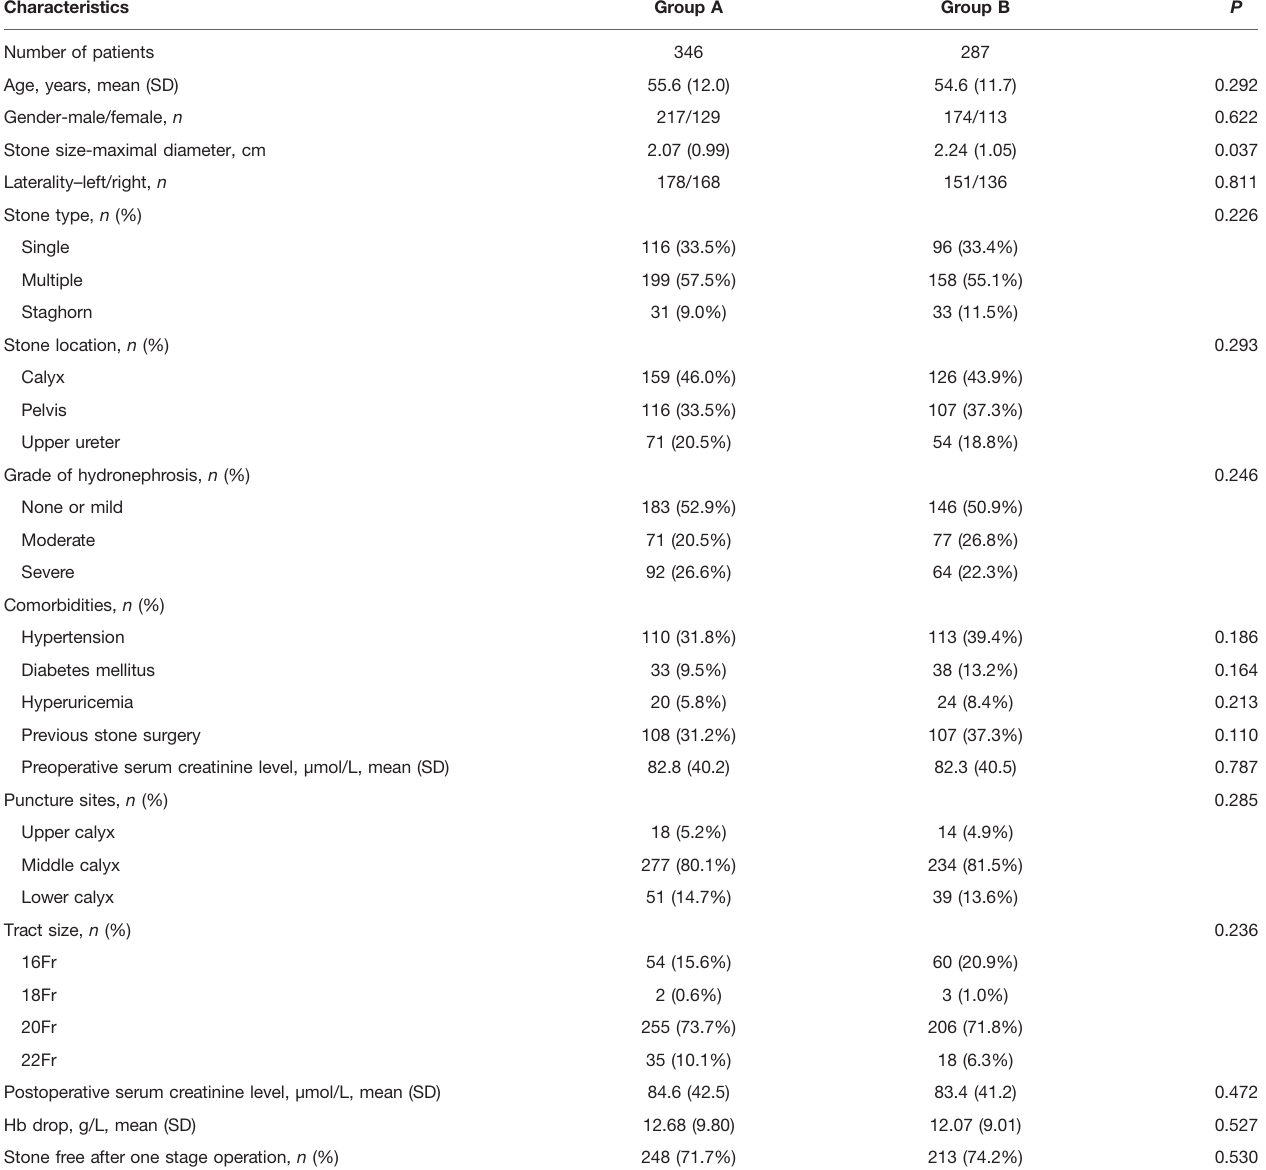
TABLE 1 | Patients ’ demographic, operative and postoperative clinical